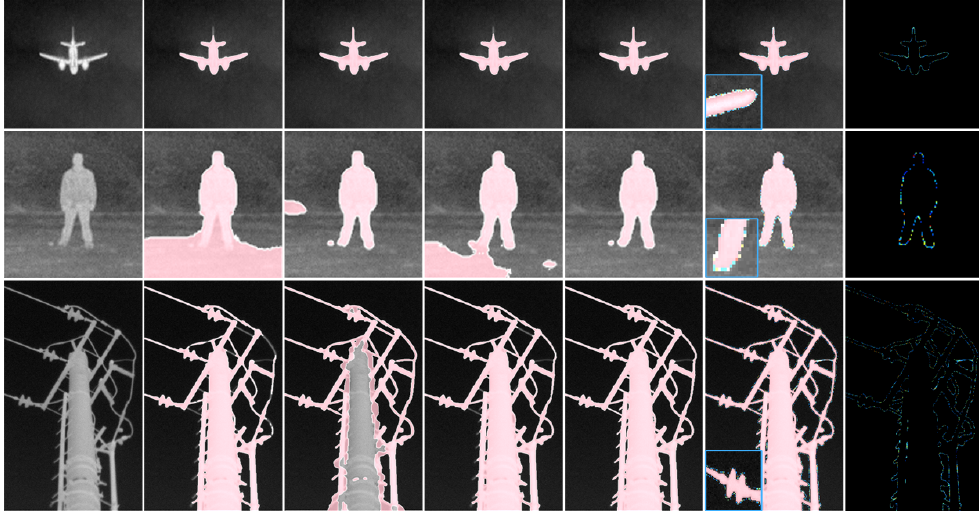
Figure 4. The comparison results on infrared images. The first column is the images to be segmented, the middle five columns are the segmentation result of the five methods (CV [8], RSF [11], FEBAC [15], RLSF [31], and ours) and the last column is the uncertainty degree generated by our